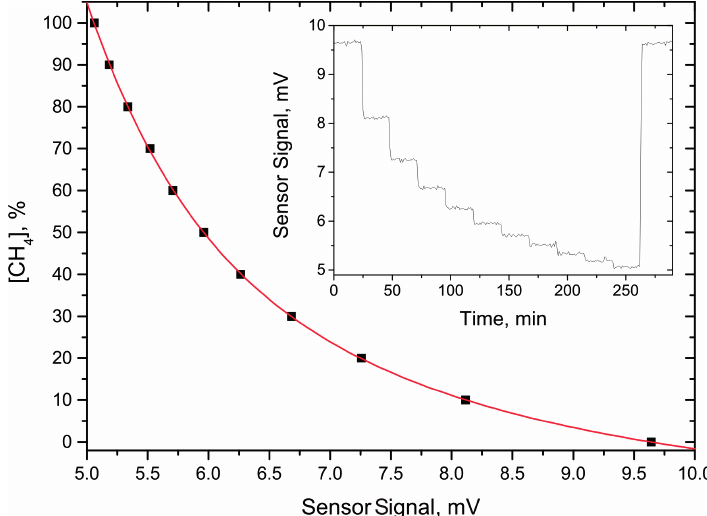
Figure 4. Concentration dependent measurement for the CH 4 absorption-QEPAS sensor. The dots represent the averaged sensor signal at each gas concentration; the red line shows an exponential fit to these values. The inset depicts the time dependent raw data.